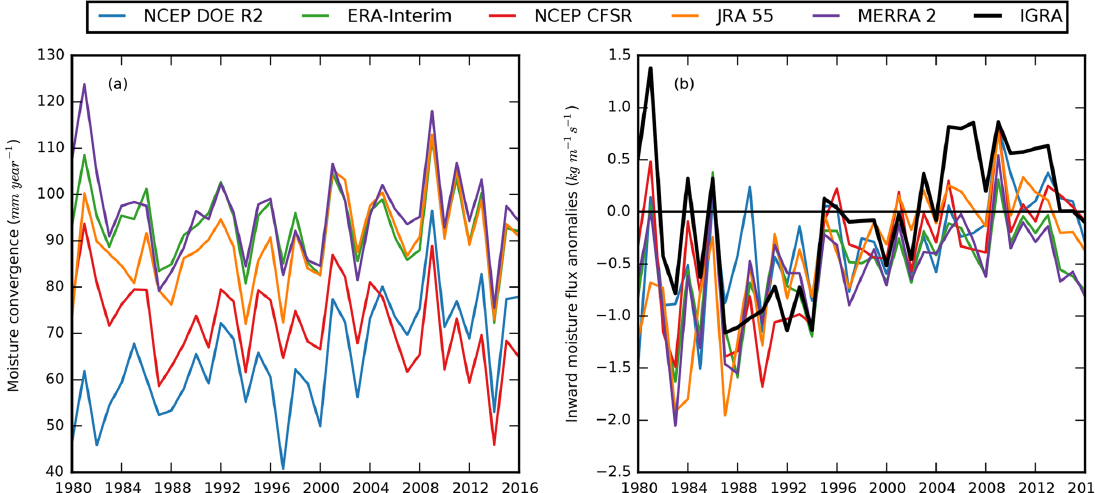
Figure 11. Time series of transport into East Antarctica: (a) absolute amounts computed from reanalyses averaged over the domain boundary, (b) anomalies of observations and reanalyses (with the same spatial and temporal sampling) averaged over all